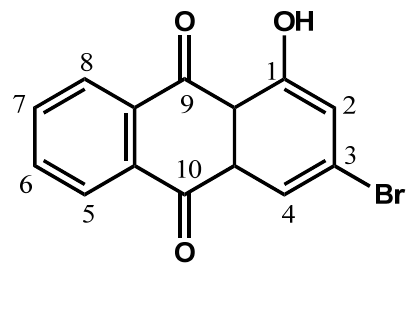
Figure 1. Molecular structure of